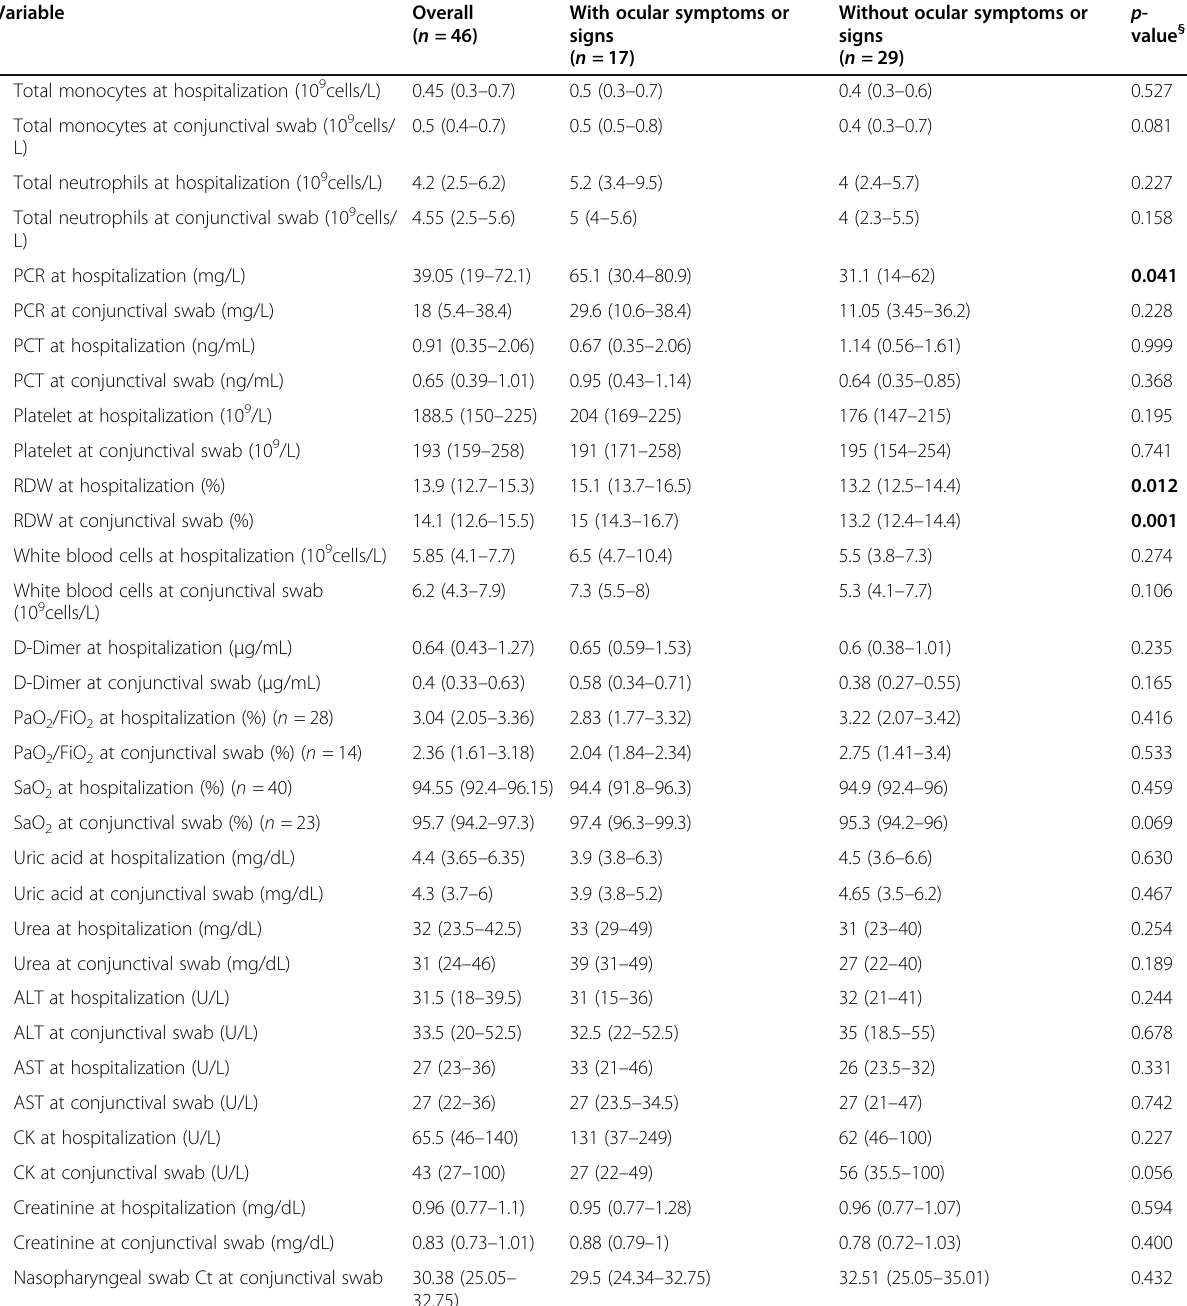
Table 1 Patients ’ characteristics according to the presence of ocular symptoms